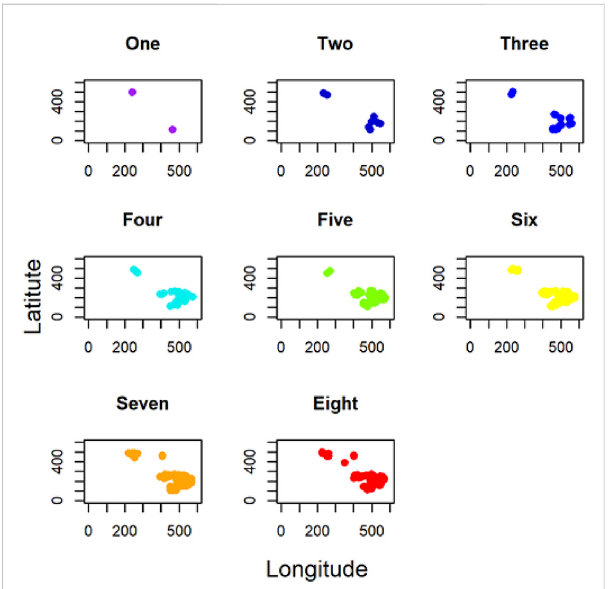
FIGURE 4 2D plots indicating the number of signi fi cant gene-sets across the tumor space for COL11A1 at high CAF level.